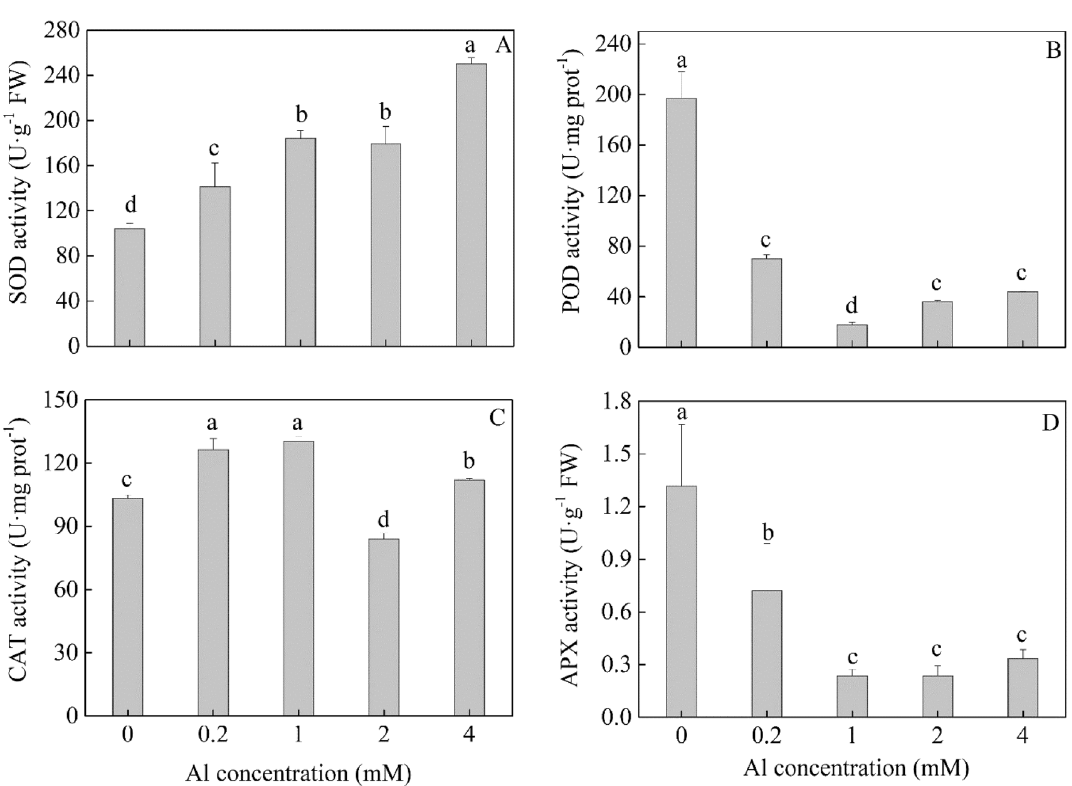
Figure 2. Effect of Al on SOD ( A ), POD ( B ), CAT ( C ), and APX ( D ) activities in tea plant leaves. Values with the same letters are not significantly different (at α = 0.05) from each